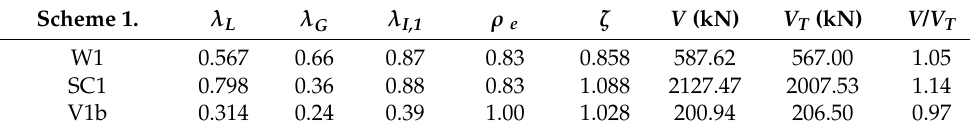
Table A18. Analysis results of test specimens reported by Wang et al. [30], Sause [8] and Hannebauer [31]. Scheme